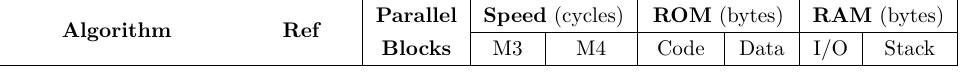
Table 4: Constant-time implementation results on ARM Cortex-M3 and M4 for various versions and representations of GIFT , as well as other lightweight block ciphers. For encryption routines, speed is expressed in cycles per block. Emboldened (resp. italic) results refer to speed (resp. code size) oriented